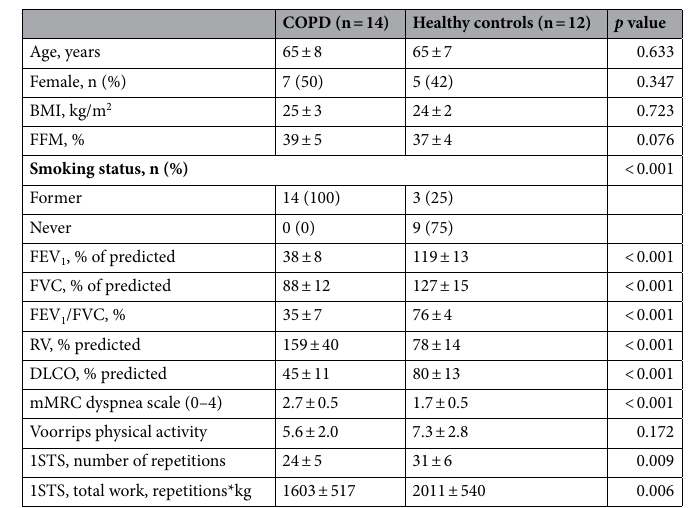
Table 1. Characteristics of study participants. Data are presented as mean ± SD or number (percentages). FFM Fat-free mass,